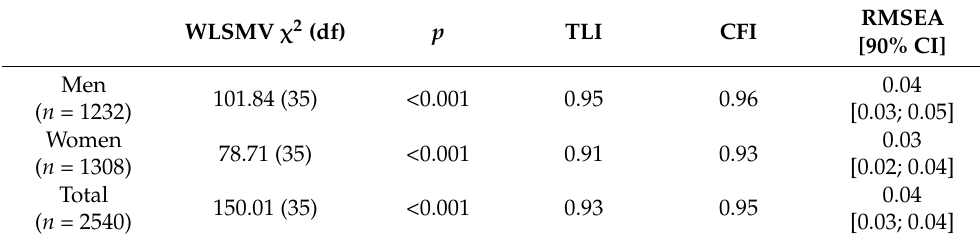
Table 2. Fit indices for confirmatory factor analyses.